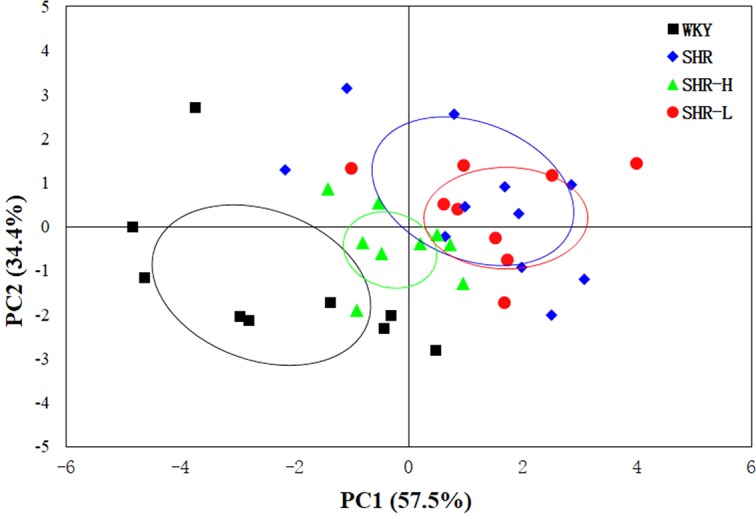
The PCA score plot for 1H NMR data showed a clear separation between the WKY-N and SHR-N groups along PC1.